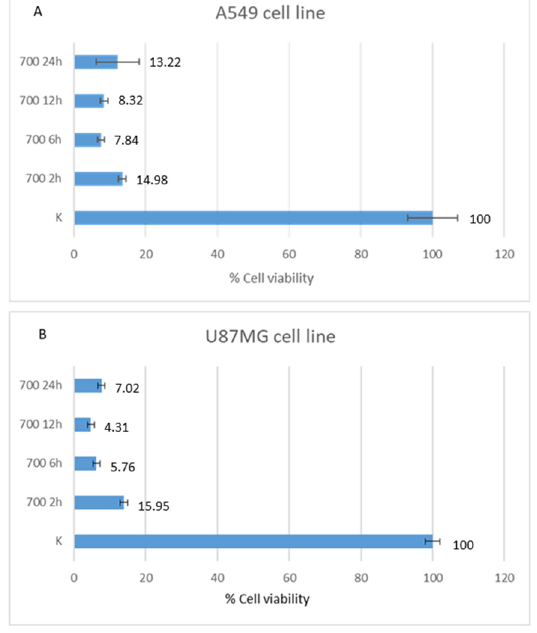
Figure 4. Viability comparison between human lung adenocarcinoma (A549, A ) and glioblastoma (U87MG, B ) cell lines treated with HOO for different times (2, 6, 12, and 24 h).